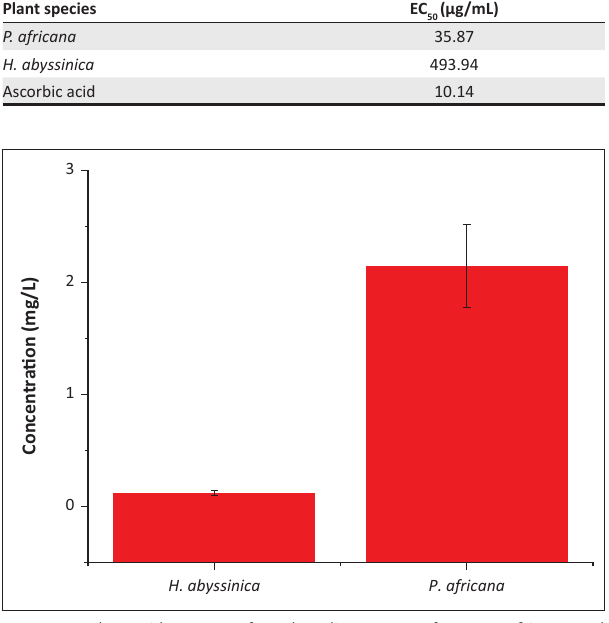
FIGURE 8: Flavonoid content of methanolic extracts of Prunus africana and Harrisonia abyssinica